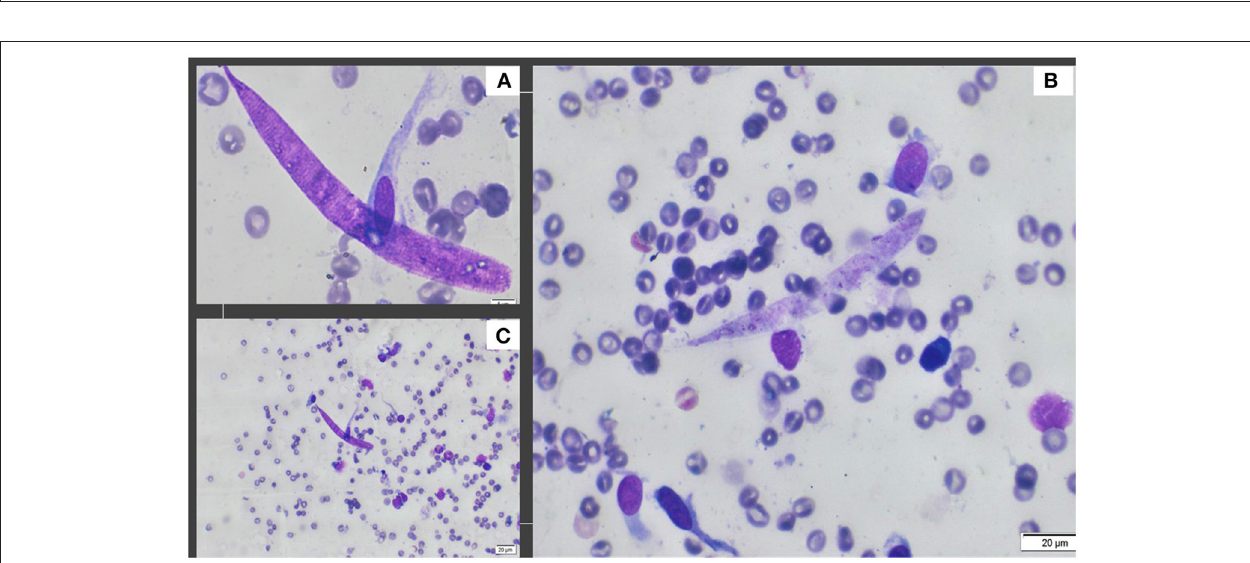
FIGURE 1 | Clinical aspect before and after the surgical removal of the nodule. (A) The presence of a conjunctival nodule; (B) The nodule was excised during surgery; (C) The aspect of the dogs’ eye after the nodule was removed.